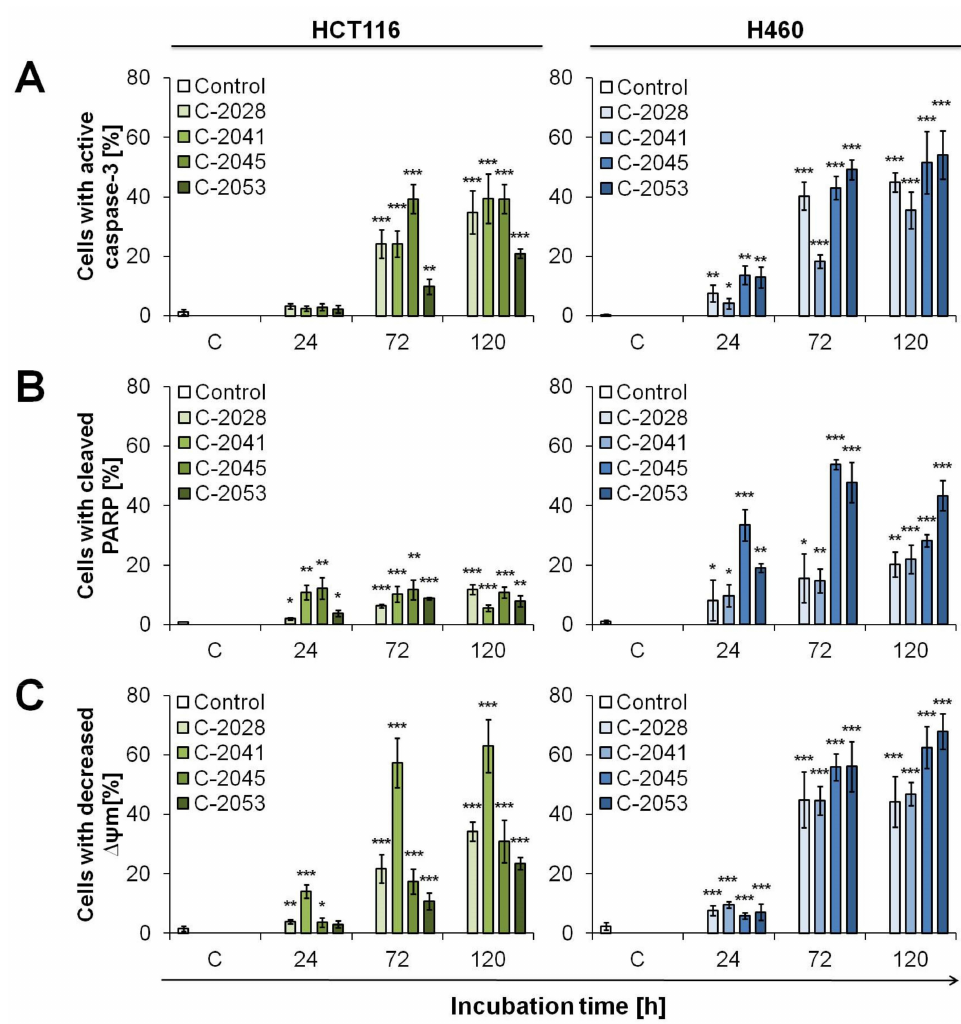
Figure 8. Cellular response in HCT116 and H460 cells induced by UA compounds. Cells were exposed to 0.04, 0.05, 0.4 and 0.2 µ M of C-2028, C-2041, C-2045 and C-2053 compounds, respectively, for the times indicated and then subjected to appropriate staining and flow cytometry analysis described in detail in the Materials and Methods section. Bar graphs show quantified data, expressed as the percentages of cells with ( A ) active caspase-3, ( B ) cleaved PARP and ( C ) decreased mitochondrial transmembrane potential ( ∆Ψ m). Significantly different from the control at: * p < 0.05; ** p < 0.01; *** p < 0.001; ( n ≥